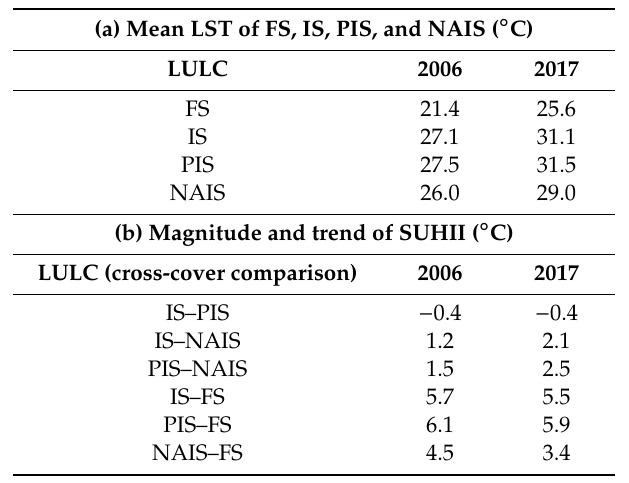
Table 5. (a) Mean LST of FS, IS, persistent IS (PIS), and newly added IS (NAIS); (b) magnitude and trend of surface urban heat island intensity